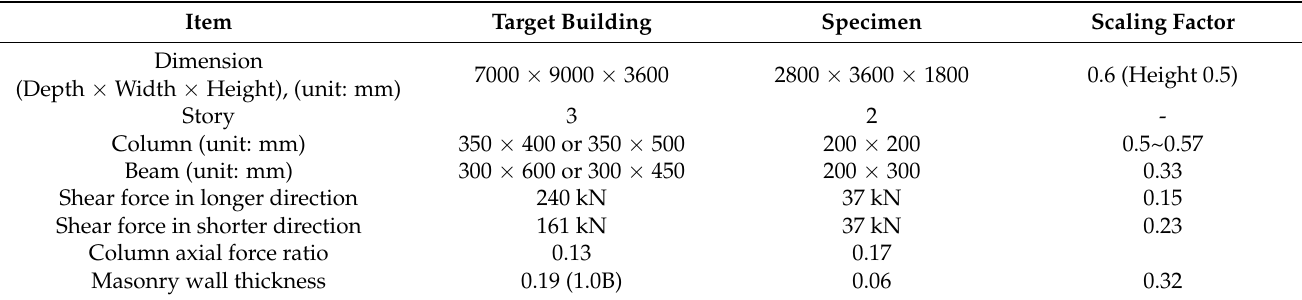
Table 1. Design of